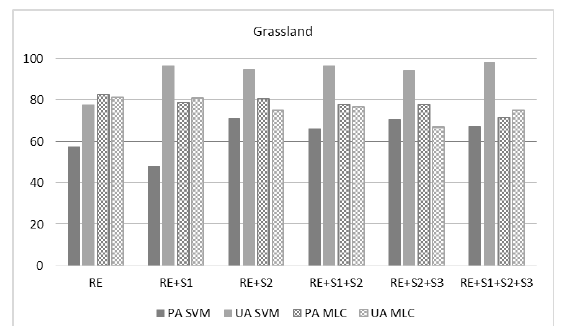
Figure 5. Producer´s and user´s accuracies for grassland for all image